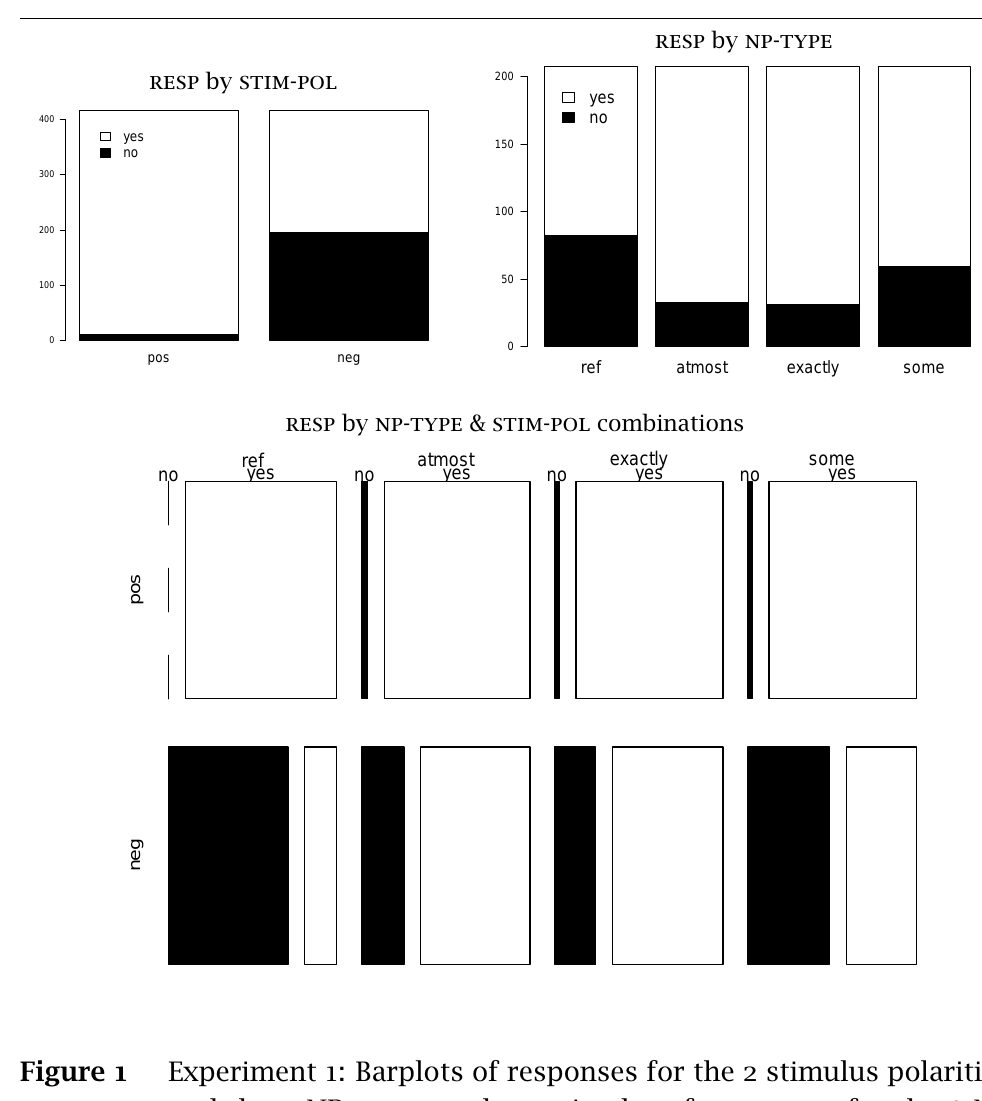
Experiment 1 : Barplots of responses for the 2 stimulus polarities and the 4 NP types, and mosaic plot of responses for the 8 NP type & stimulus polarity